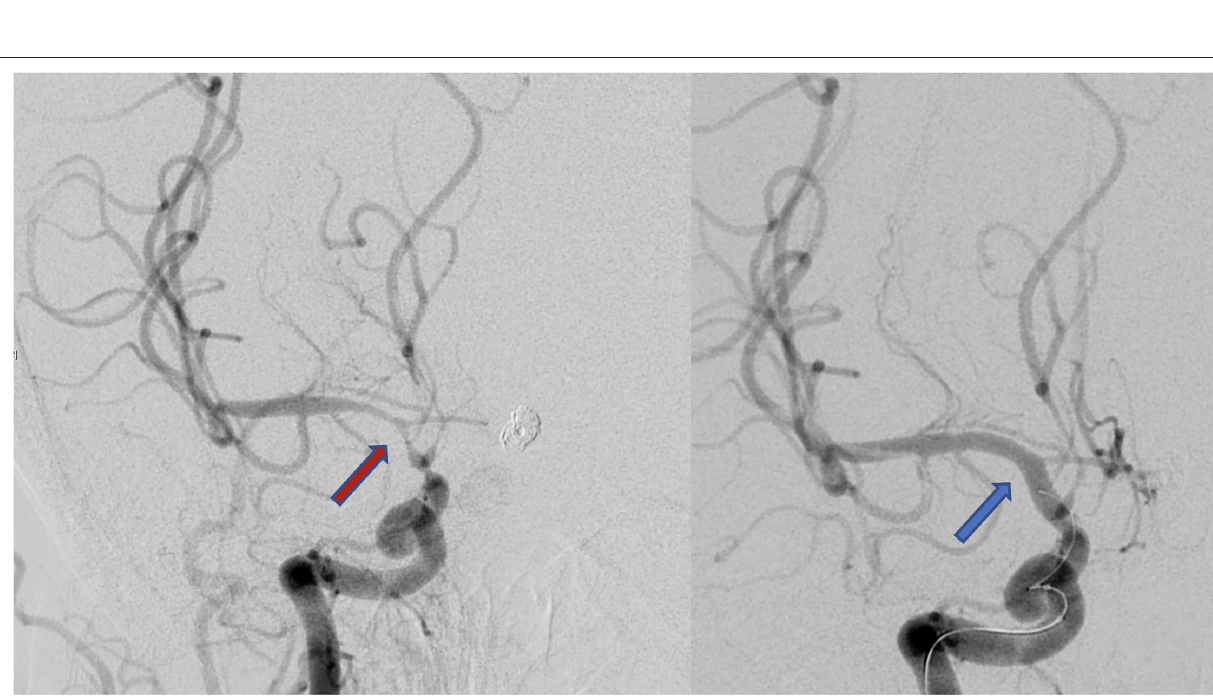
Frontiers in Neurology |